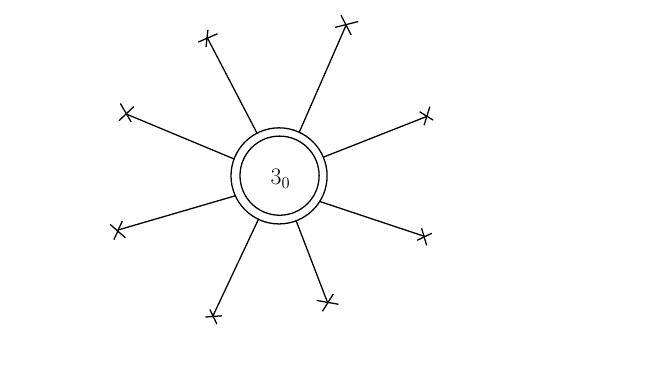
Figure 6 . The theory of eight copies of T x with SU(3) = Z 3 gauged at level zero, dual to a WZ model with fourteen chiral